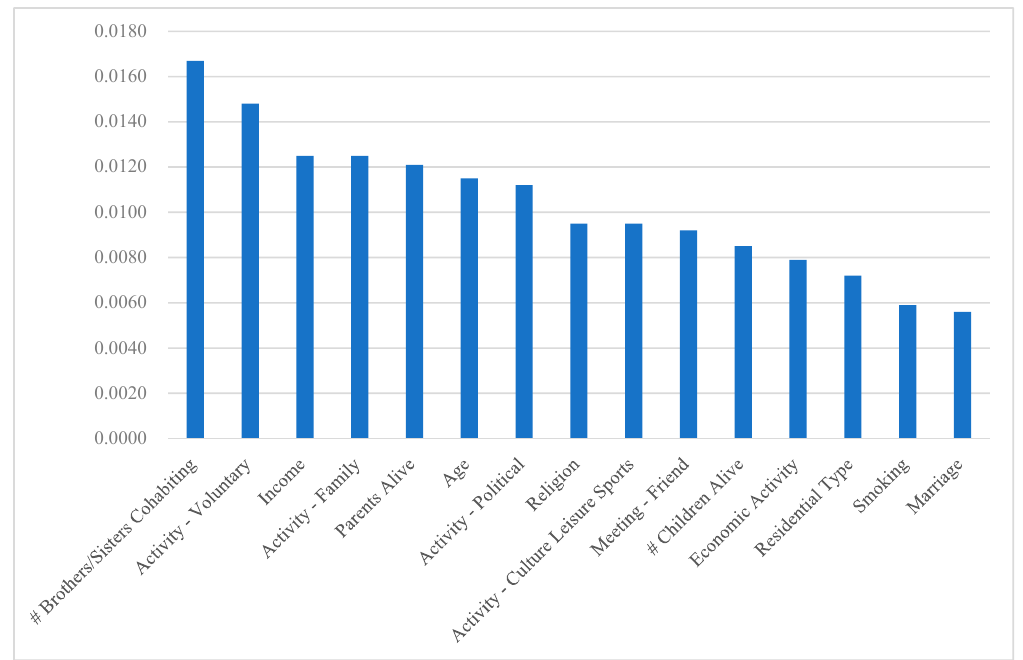
Figure 1. The variable importance from the Artificial Neural Network, # means the number